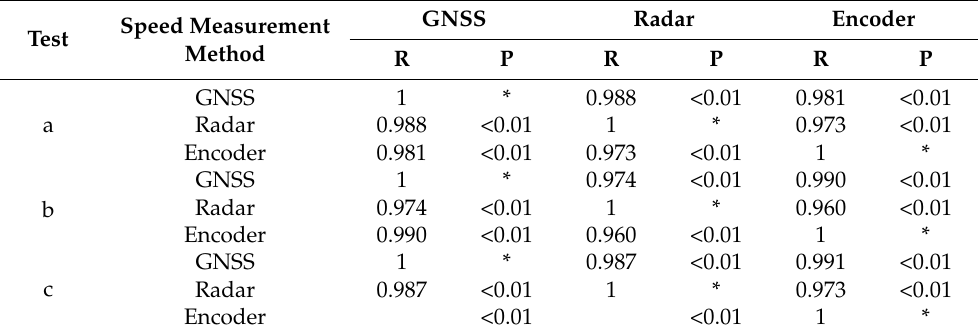
Table 7. Pearson correlation analysis results of the real-time seeding spacing monitoring values of the three speed measurement methods. Speed Measurement Test